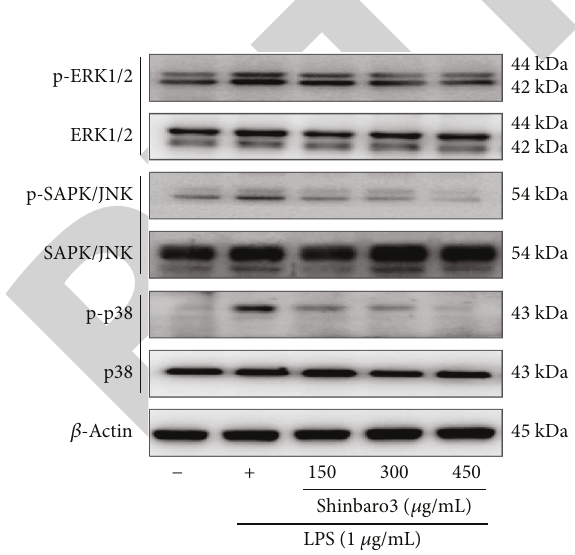
Figure 5: E ff ects of Shinbaro3 on MAPK phosphorylation in LPS-stimulated RAW 264.7 cells. RAW 264.7 cells were treated with LPS (1 μ g/mL) and Shinbaro3 (150, 300, and 450 μ g/mL) for 2h. Total cell lysates were analysed via Western blotting using antiphospho-ERK1/2, antiphospho-SAPK/JNK, and antiphospho- p38 antibodies. β -Actin was used as an internal control. The data are representative of three separate